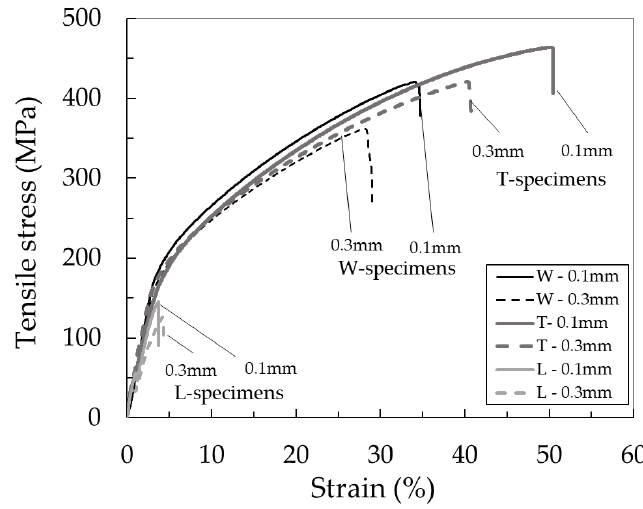
Figure 5. Tensile stress–strain curves of the silver parts printed in various layer directions and thicknesses.